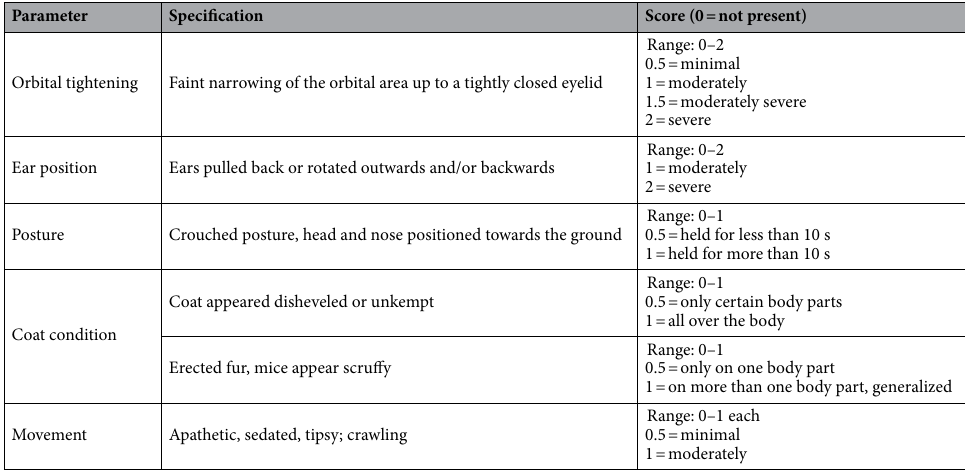
Table 1. Composite pain